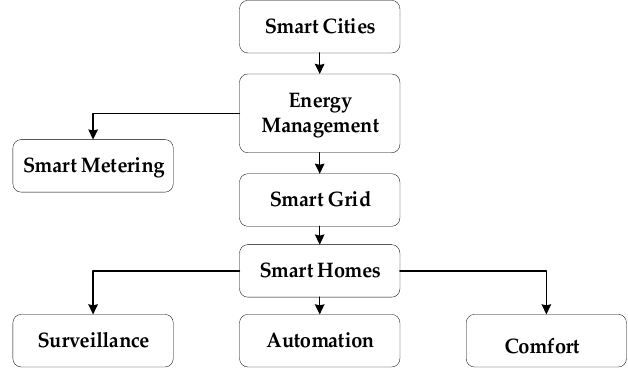
Figure 4. Role of optimization in smart homes.